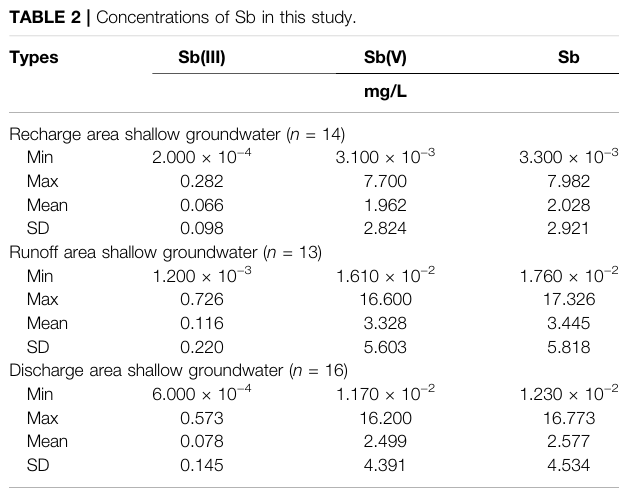
TABLE 2 | Concentrations of Sb in this